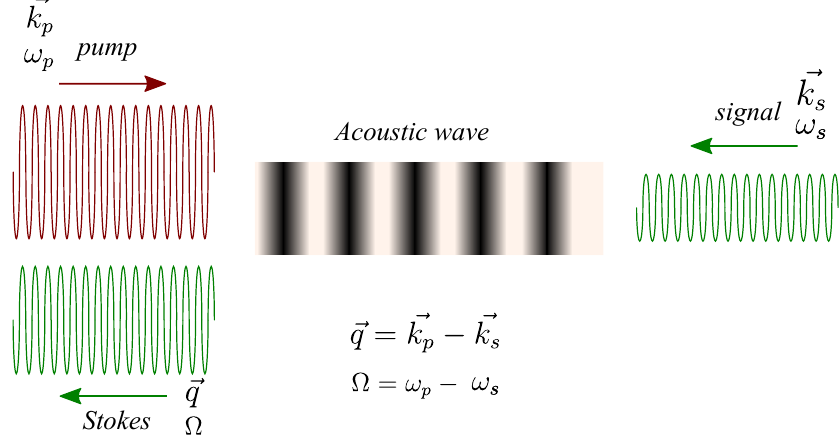
Figure 1. Backward Brillouin scattering under phase-matching and energy conservation